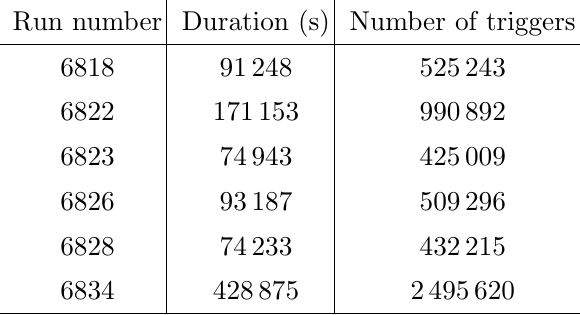
Table 1 . Summary of the data used in this